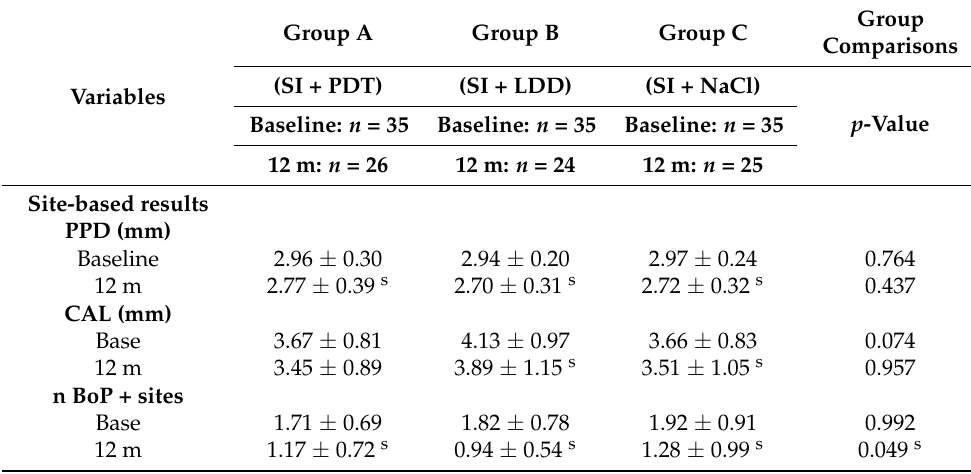
Figure 1. Flowchart of the study (FMPS: full-mouth plaque score; SI: subgingival instrumen- tation; LDD: local drug delivery; PDT: photodynamic therapy). SPT = supportive periodontal therapy; SD = subgingival debridement within 2 consecutive days; PDT = photodynamic therapy; LDD = locally delivered drug; m = months; d = days. Table 1. Mean values and standard deviations for site-based and full-mouth clinical